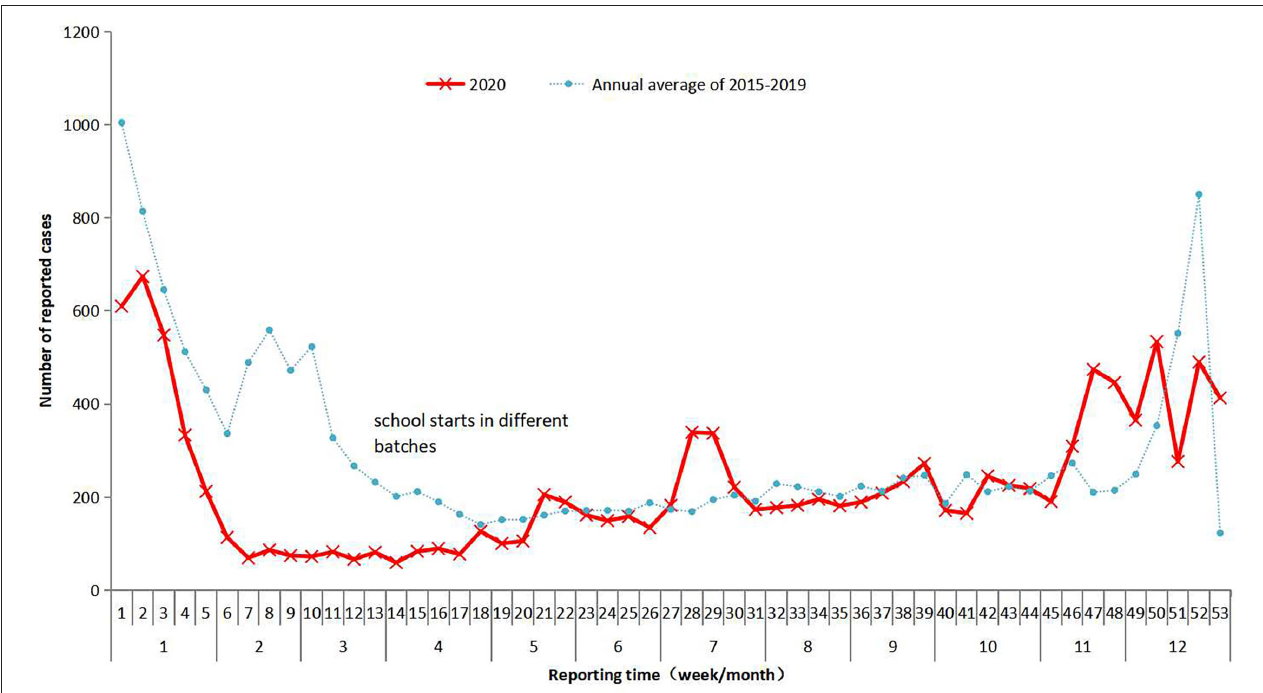
FIGURE 1 | The monthly number of reported cases of infectious diarrhea in Guangzhou, 2015–2020. The average annual number of reported cases of infectious diarrhea in Guangzhou during 2015–2019 is represented by the blue dotted line. The monthly number of reported cases of infectious diarrhea in Guangzhou in 2020 is represented by the red